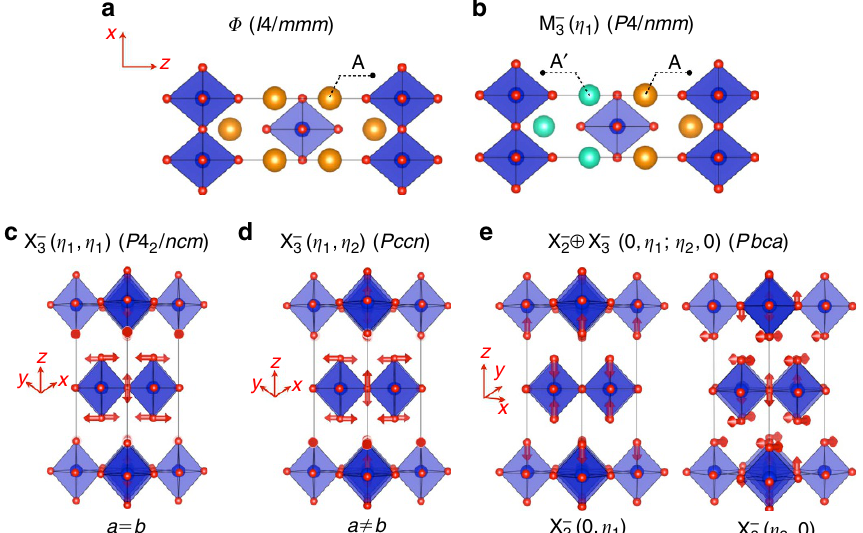
Figure 3 | A/A 0 cation ordering and octahedral tilting in the n ¼ 1 RPs for NCS materials design. ( a ) High-symmetry aristotype structure ( f , I 4/ mmm ). ( b ) One of the A/A 0 cation ordering schemes (irrep: M (cid:3) ( Z 1 ); space group (s.g.): P 4/ nmm ). ( c ) Out-of-phase octahedral tilting (oxygen displacements 3 indicated using arrows) (irrep: X þ ( Z 1 , Z 1 ); s.g.: P 4 2 / ncm ) and lattice constants a and b are of equal length. ( d ) Out-of-phase octahedral tilting 3